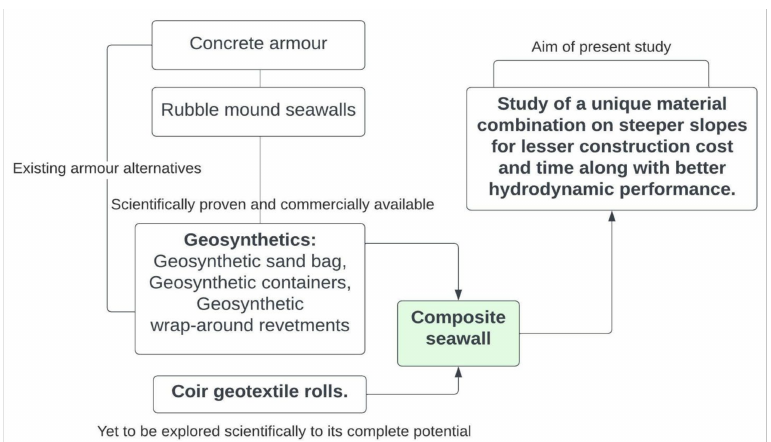
Figure 1. Composite seawall armor in the present